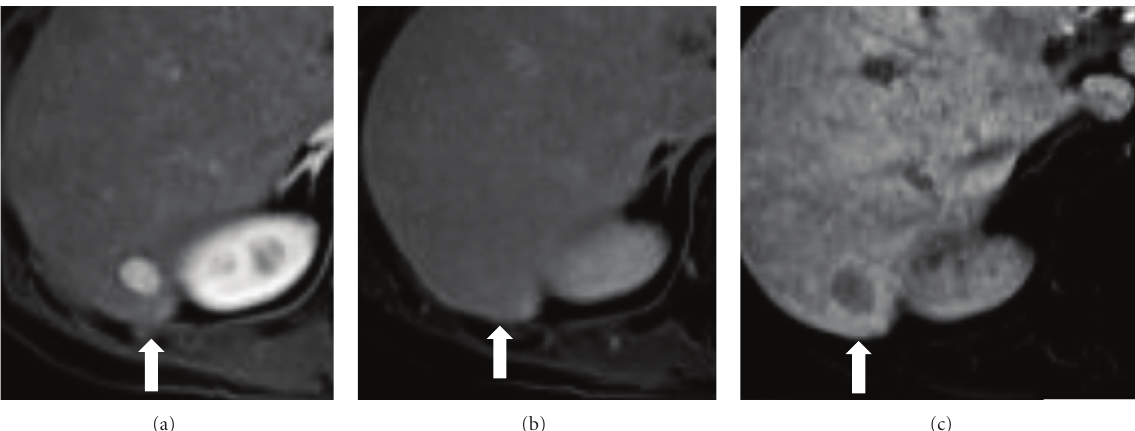
Figure 1: (a) Gadoxetate acid-enhanced MRI in the arterial phase in a 51-year-old male with alcoholic liver cirrhosis showing a hyperenhancing nodule in the liver segment 6. (b) Equilibrium phase imaging shows isointense appearance with no hypointense washout. The diagnosis of HCC is therefore not confirmed in the dynamic vascular phases. (c) Hepatobiliary phase imaging at 20 minutes after injection shows a hypointense nodule against the background of enhancing liver parenchyma, implying lack of lesional uptake. This additional information allowed more confident diagnosis of HCC. Final histopathology was a well-di ff erentiated Edmondson-Steiner grade I